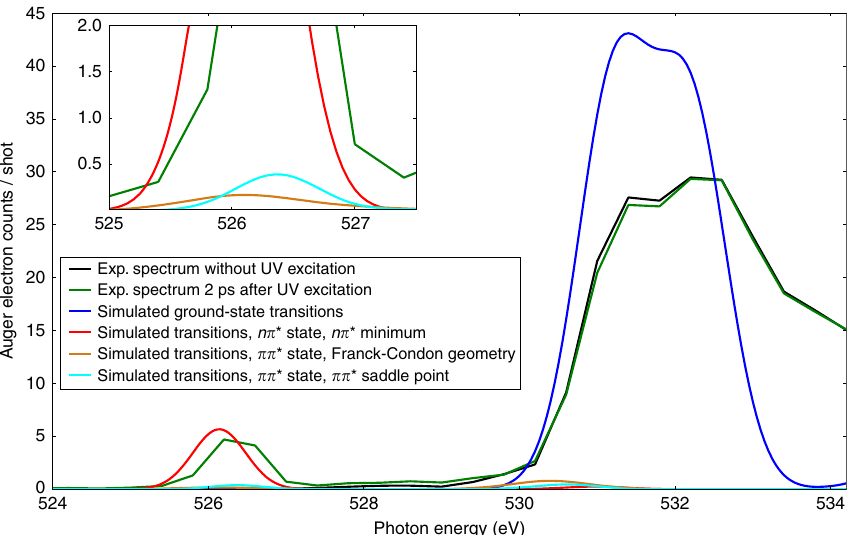
Fig. 4 Comparison of experimental and simulated spectra. Simulated near-edge absorption fi ne structure spectra of the ground state, the ππ * state in the Franck – Condon region and at the saddle point, and the n π * state at its minimum. For comparison, the experimental ground-state spectrum and the experimental spectrum 2 ps after ultraviolet (UV) excitation are shown. Relative intensities of simulated and experimental ground-state spectra are adjusted to an equal peak area of the π * resonances. Simulated excited-state spectra are scaled with respect to the ground-state spectrum assuming 13% excitation. The inset shows a detailed view of the intensity relations at the position of the excited-state feature. Contributions from K-edge ionization were not included in the